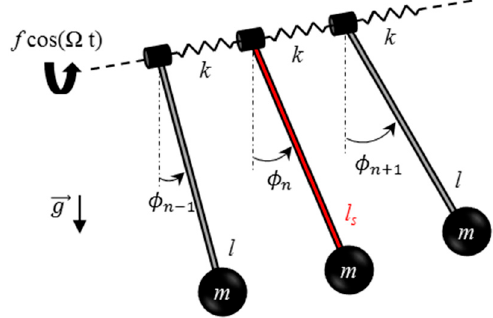
Figure 1. Periodic nonlinear coupled-pendulums chain with imperfection.